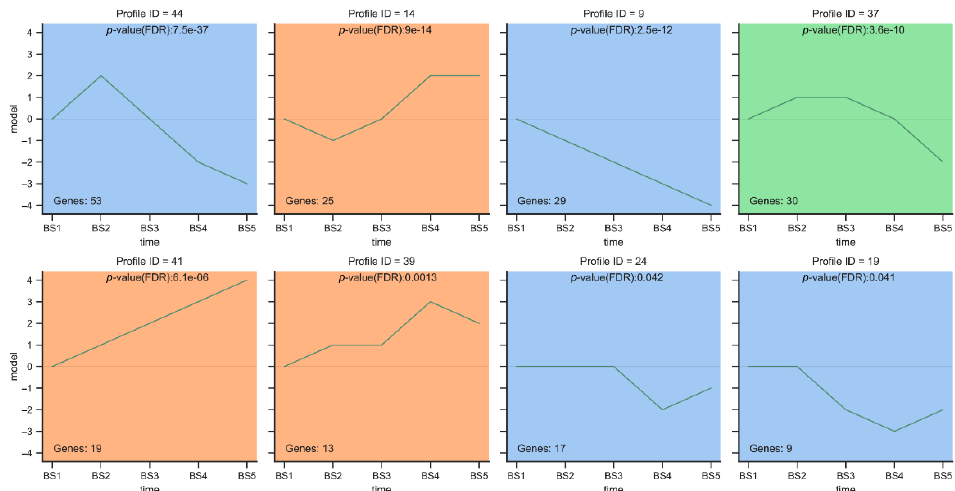
Figure 6. Trend analysis expression module of DEGs. The horizontal axis represents the five periods of flower development, and the vertical axis represents the changes in gene expression at different periods. Different colors indicate different expression patterns ( p ≤ 0.05).